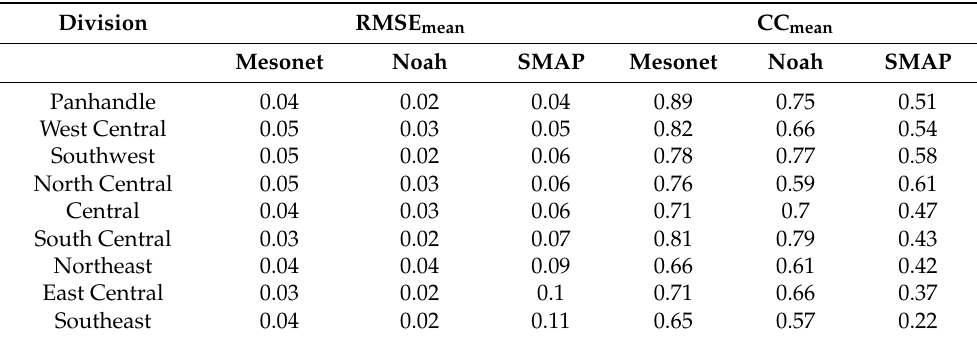
Table 5. Climate-division averaged CC and RMSE from the TC triplets at local 6:00 a.m. from April 2015 to July 2019, for Mesonet, Noah, and SMAP during the spring season months (i.e., March, April, and May) for nine climate divisions in Oklahoma.